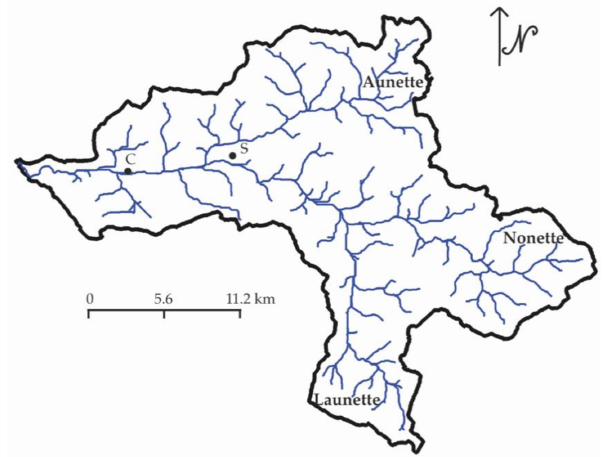
Figure 1. Nonette catchment with the three main rivers: Nonette, Aunette and Launette. C refers to Chantilly domain and S to the city of